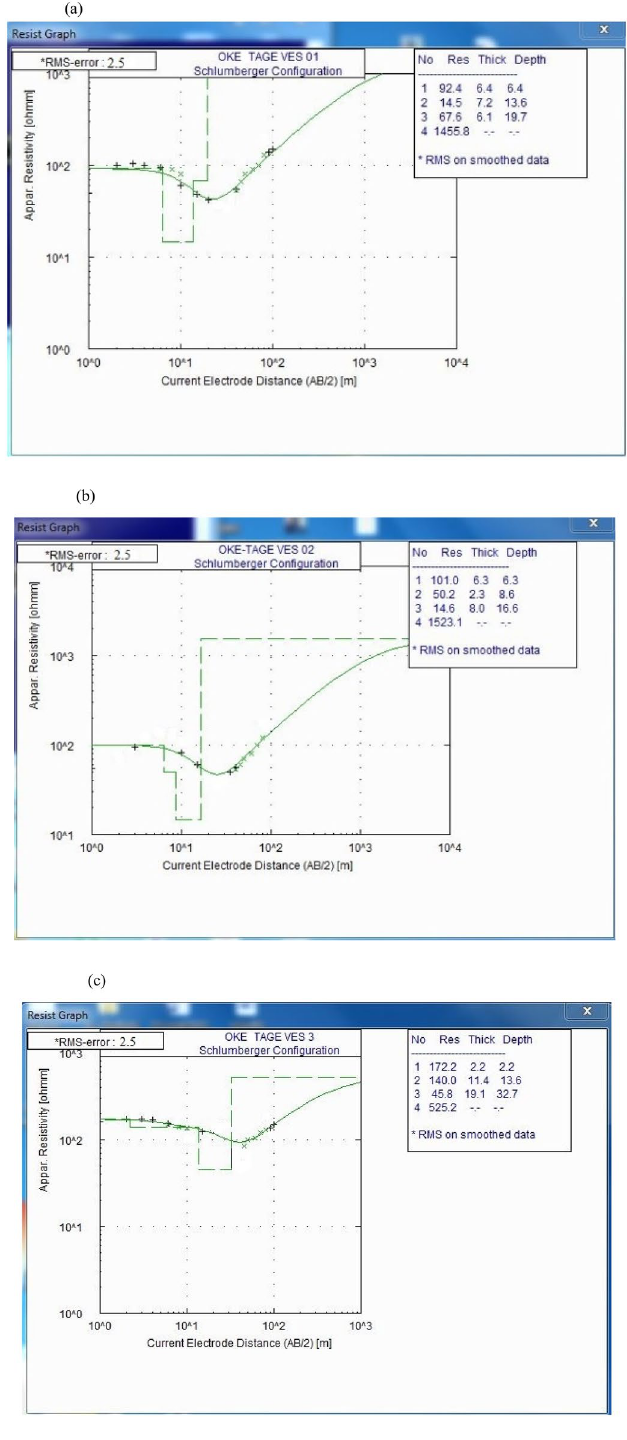
Figure 4. 1D Model of ( a ) VES 1 ( b ) VES 2 ( c ) VES